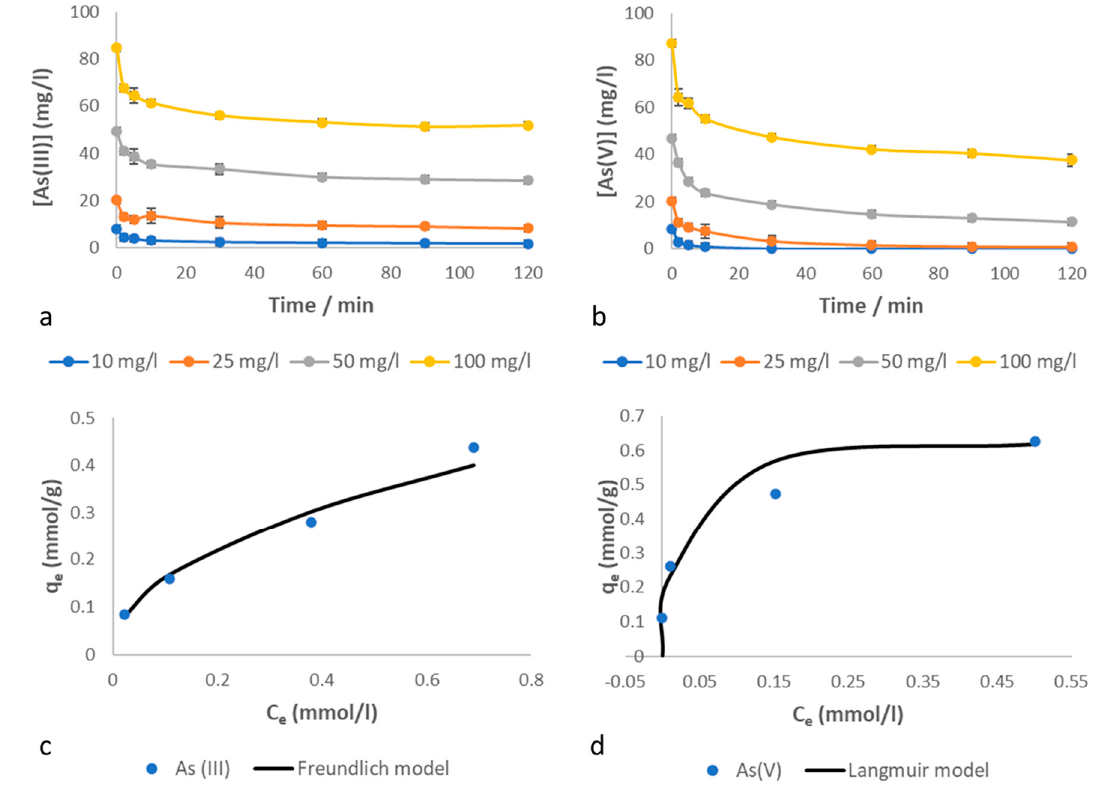
Figure 3. Effect of arsenic concentration on adsorption by biogenic iron precipitates (1 g/L of adsorbent) from ( a ) arsenite solutions at pH 10 and ( b ) arsenate solutions at pH 2. Experimental data and predicted adsorption isotherms: ( c ) As(III) fitted to Freundlich model and ( d ) As (V) fitted to non-linear Langmuir